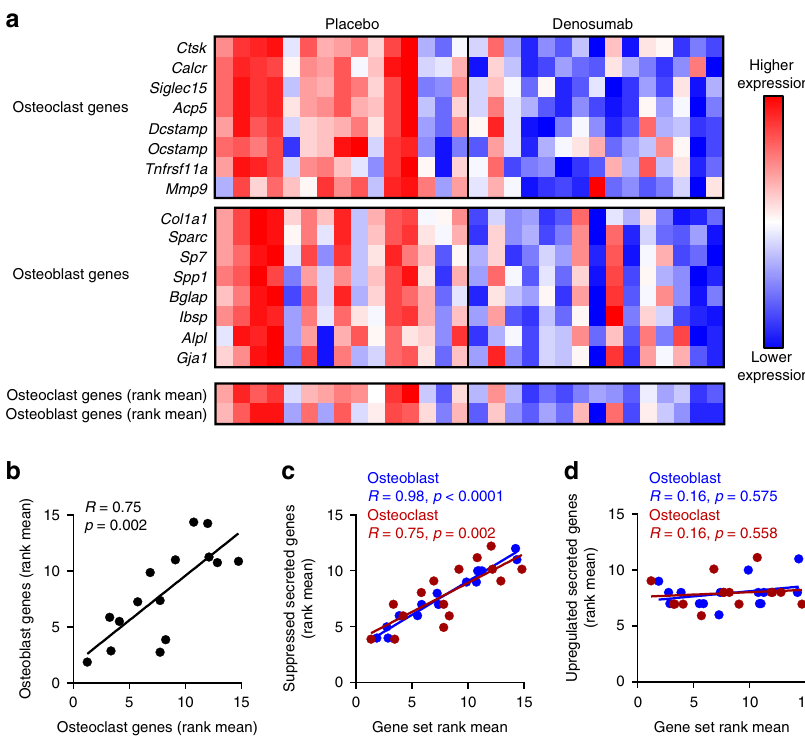
Fig. 2 Correlation of osteoclast and osteoblast genes and secreted factors altered by DMAb. a Heat maps showing the osteoclast and osteoblast normalized gene expression in placebo and DMAb-treated participant bone biopsies. Normalized gene expression (CQN values) were ranked for each gene across the placebo and DMAb participant biopsies ( N = 15 participant biopsies/group). Red denotes higher expression and blue denotes lower expression. b Rank mean values for DMAb-suppressed osteoclast and osteoblast gene sets were plotted for the placebo participants. c DMAb-suppressed secreted factor genes, but not d DMAb-upregulated secreted factor genes correlate with osteoblast and osteoclast marker genes in the placebo participants ( N = 15 participant biopsies); Spearman ’ s correlation coef fi cient was used to test the strength of the relationship between rank mean gene sets in b – d . Source data are provided as a Source Data fi